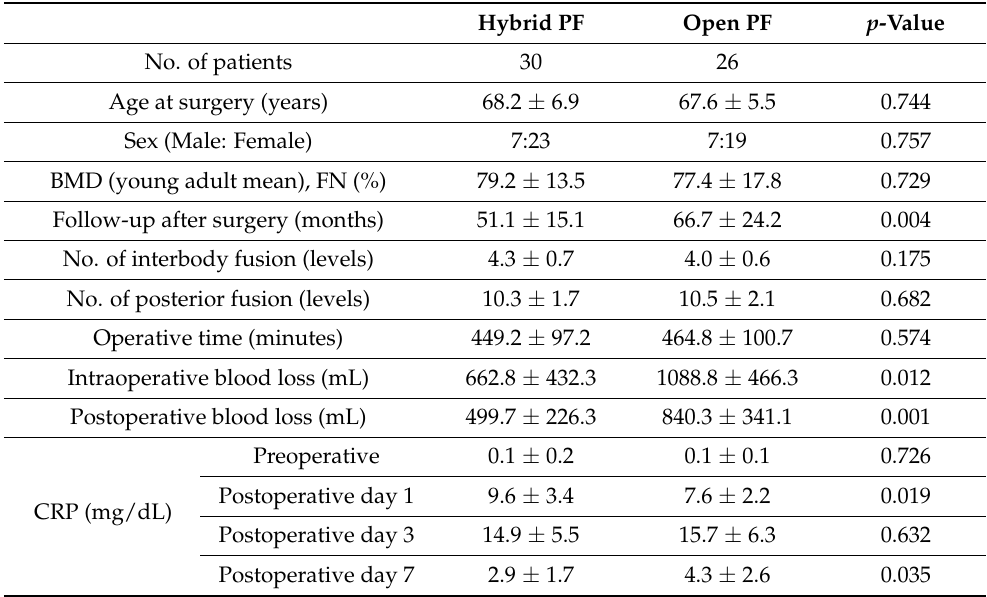
Table 1. Demographic and surgical data of patients in the hybrid PF and open PF